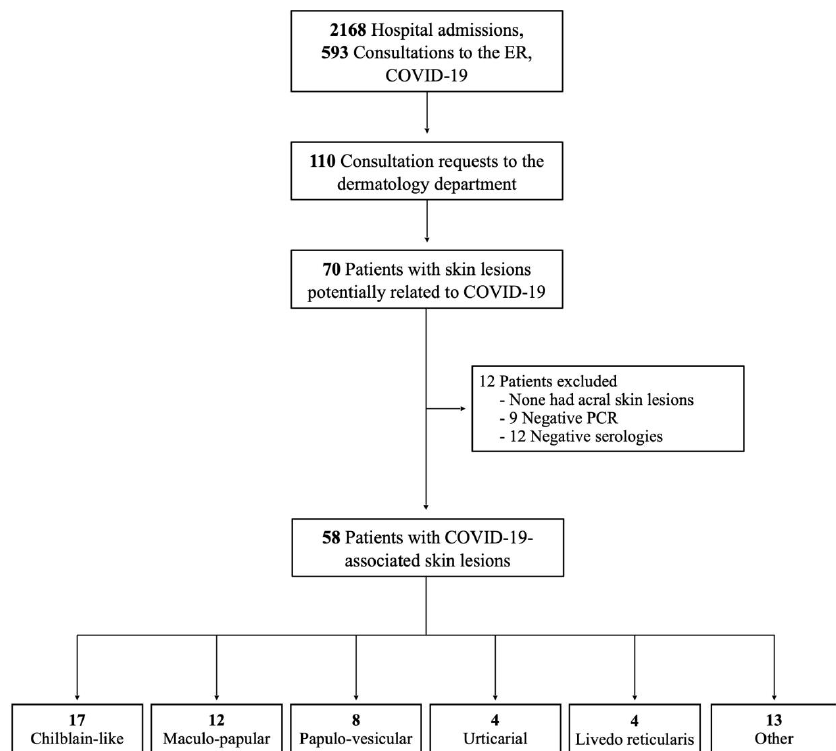
Figure 1. Patient flow chart according to STROBE